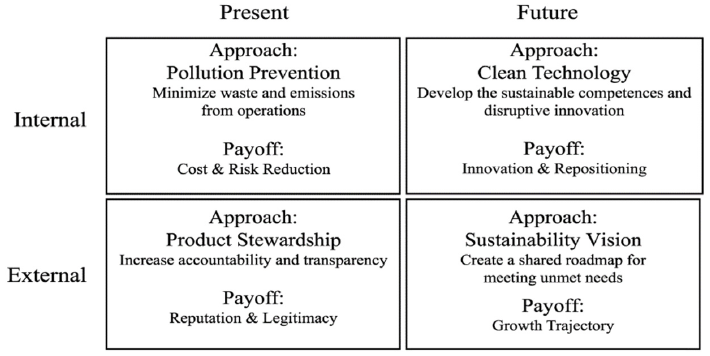
Figure 1. Hart’s (Hart [32]) strategy framework.